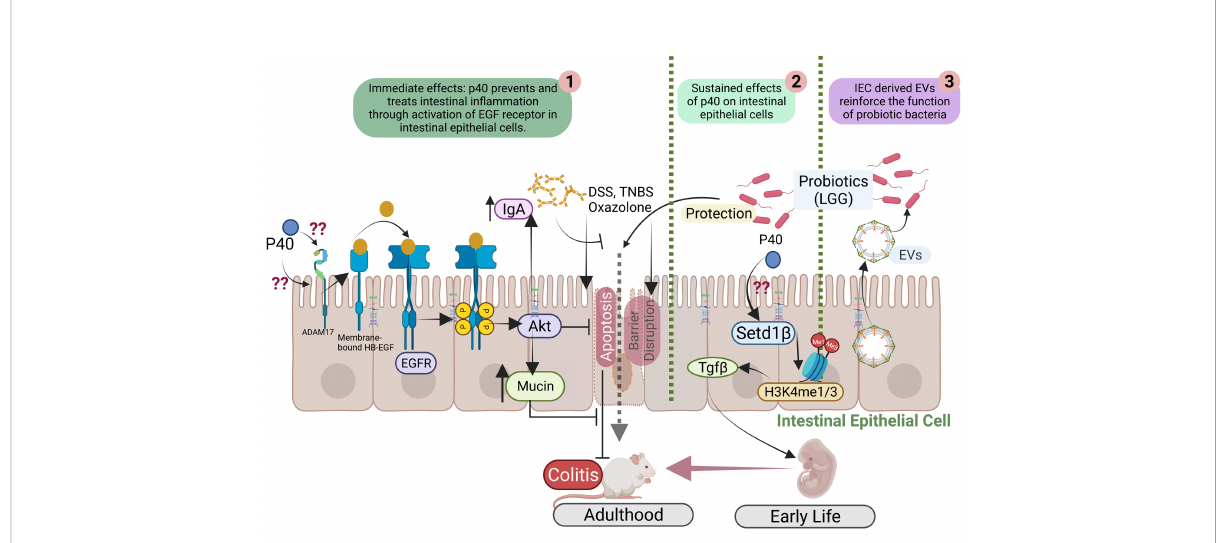
FIGURE 1 Mutual interactions between commensal bacteria and IECs. p40 is a functional factor secreted from the gut commensal bacteria. p40 has immediate effects on transactivation of EGF receptor (EGFR) and its downstream target, Akt, leading to protective responses in IECs for preventing and treating colitis (1). p40 also exerts sustained effects on IECs through upregulation of Setd1 b expression and histone 3 (H3) methylation on lysine residue (H3K4me1/3) to stimulate TGF b gene expression and protein production by IECs, thus p40 supplementation in early life prevents colitis in adulthood (2). IEC-released extracellular vehicles (EVs) communicate with commensal bacteria and promote the function of commensal bacteria